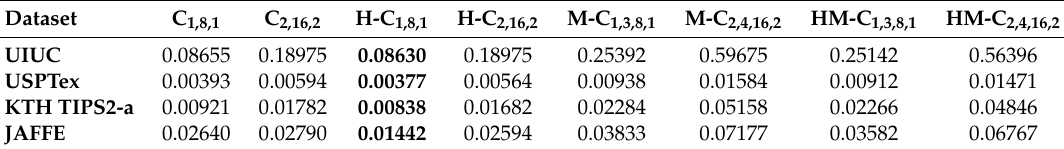
Table 8. Computational times, in seconds, for the extraction of CLOSIB variants on the four datasets evaluated. CLOSIB ( C ) and H-CLOSIB ( H-C ) with underscored parameters ( radius , neighbors , order ) . M-CLOSIB ( M-C ) and HM-CLOSIB ( HM-C ) with underscored parameters ( minRadius , maxRadius , neighbors , order )